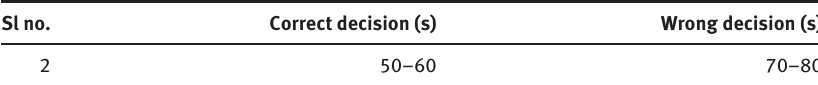
Table 10. Computational Time.